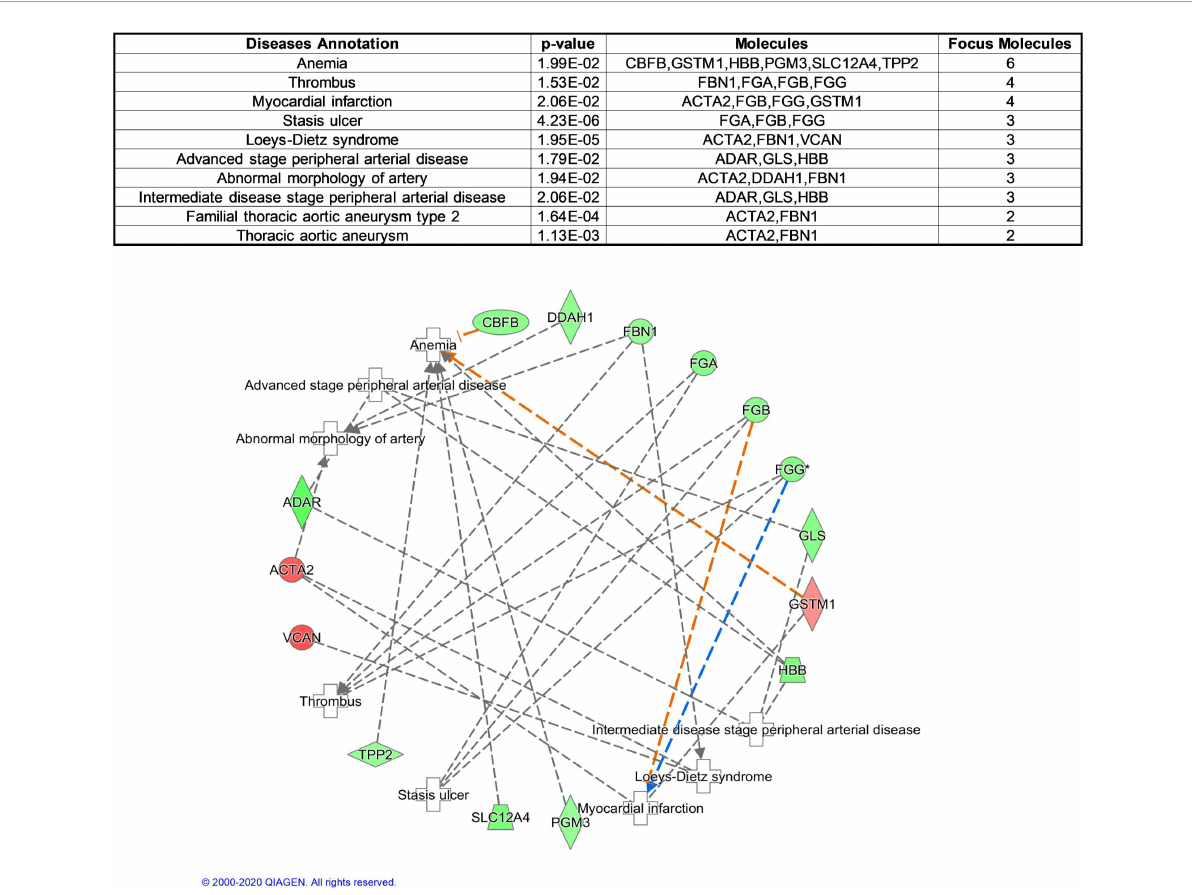
FIGURE3 Cardiovascular Disease analysis of differentially expressed proteins between normal and GDM umbilical vessels. For this developmental disease network, genes or gene products are represented as nodes , and the biological relationship between two nodes is represented as an edge . All edges are supported by at least one publication as stored in the Ingenuity Knowledge database. The intensity of the node color indicates the degree of up- (red) or down- (green)